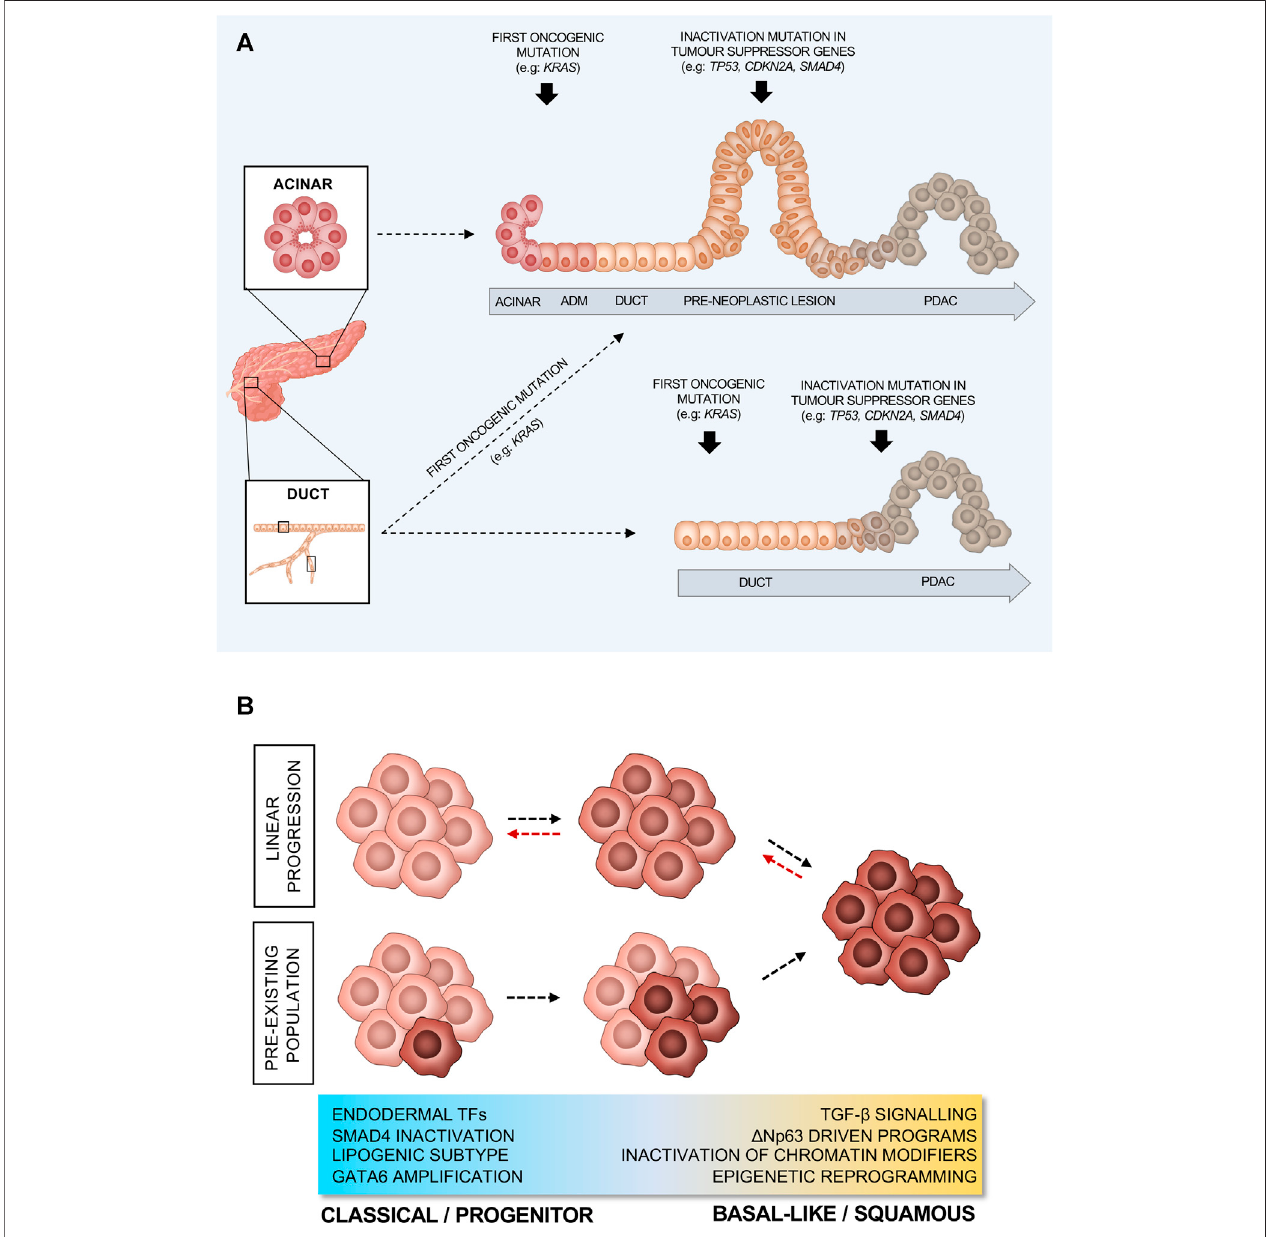
FIGURE 2 | Proposed models of PDAC progression. (A) PDAC progression from ductal or acinar cells. (B) Schematic representation of different models of PDAC evolution from classical/progenitor to basal-like/squamous subtype. Red arrows indicate switch between subtypes, in response to environmental pressures.